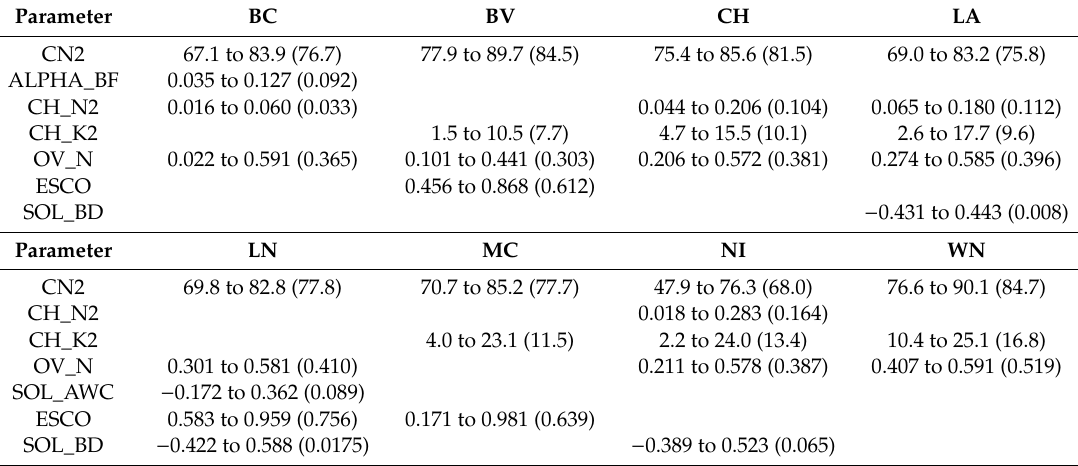
Table 8. Range and average (in parentheses) of HSP from individual year (1992 to 2015) runs.